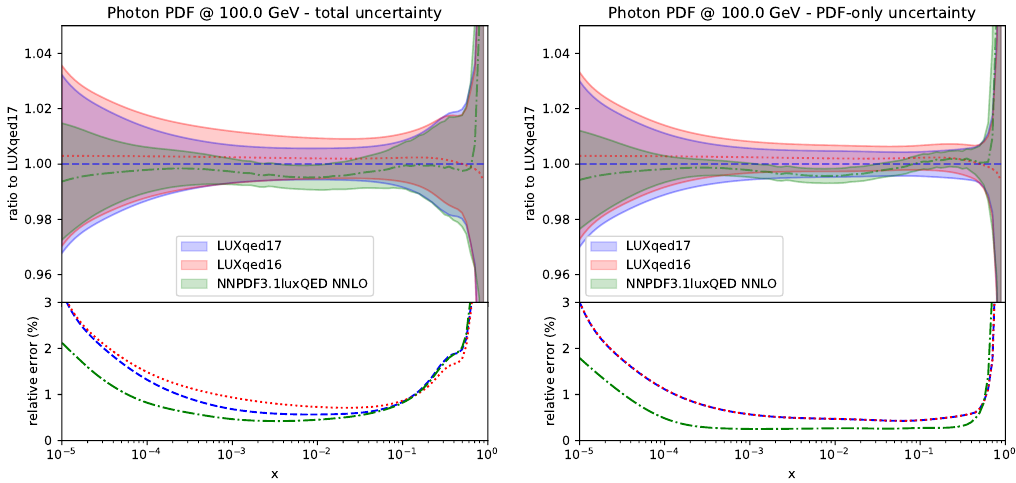
Figure 3.1: Left: comparison of the NNPDF3.1luxQED photon at Q = 100 GeV with that of LUXqed16 / 17 normalized to the central value of the latter. The bottom panel indicates the relative uncertainty on the photon PDF in each case. Right: the same comparison, now including only the uncertainties on γ ( x , Q ) related to the quark and gluon PDFs in the high- Q 2 inelastic